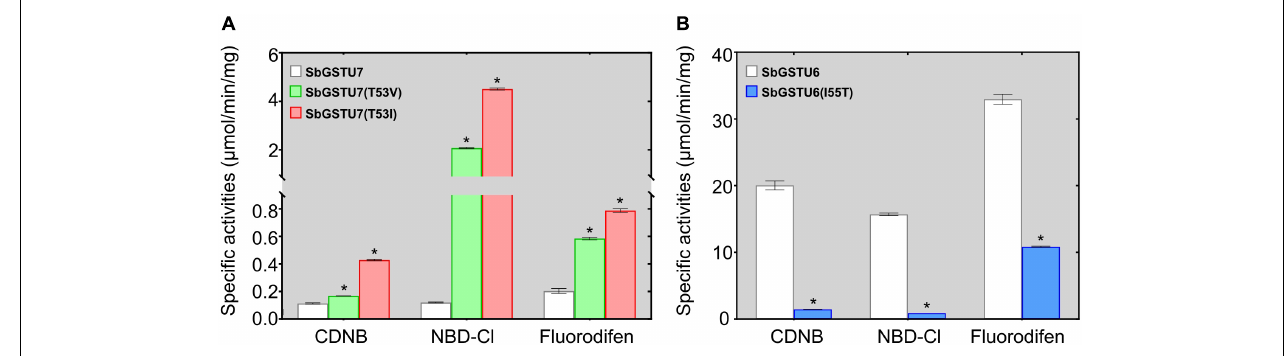
FIGURE 7 | Enzymatic activities of the SbGSTU7 mutants (A) and SbGSTU6 mutant (B) . Data for each sample represent the average of three biological replicates, and bars indicate the standard deviation; * significant difference (one tail t -test, P < 0.01) in enzymatic activities between the wild-type and its